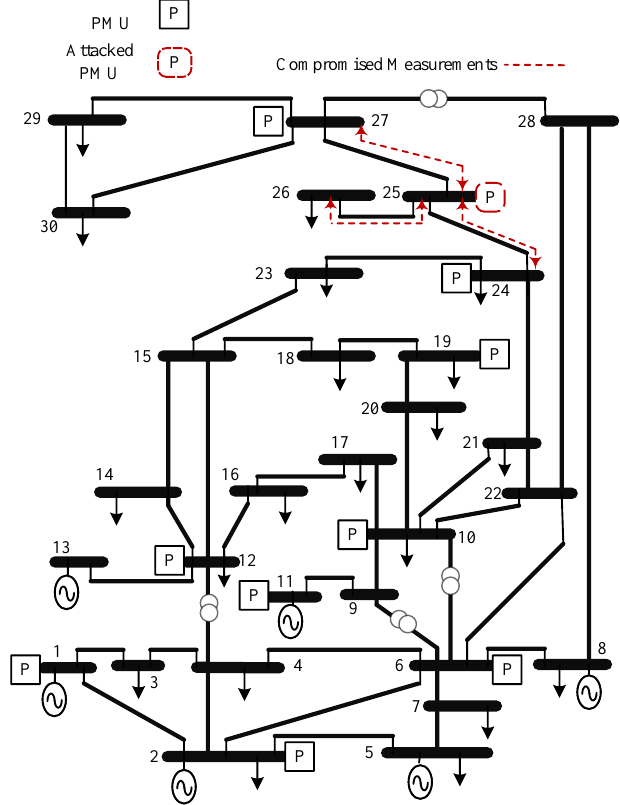
Figure 7. IEEE 30-bus with PMU